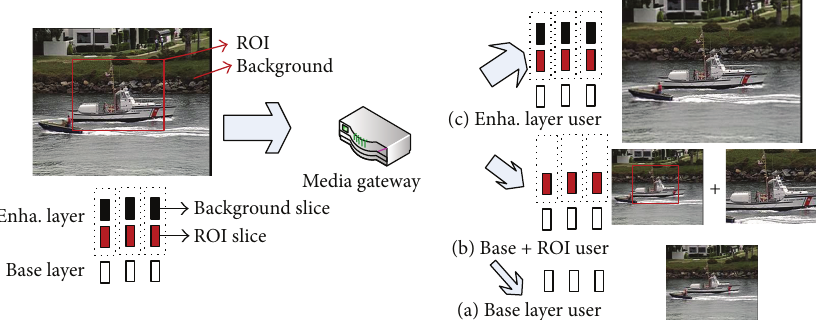
Figure 1: Application scenarios for SVC with